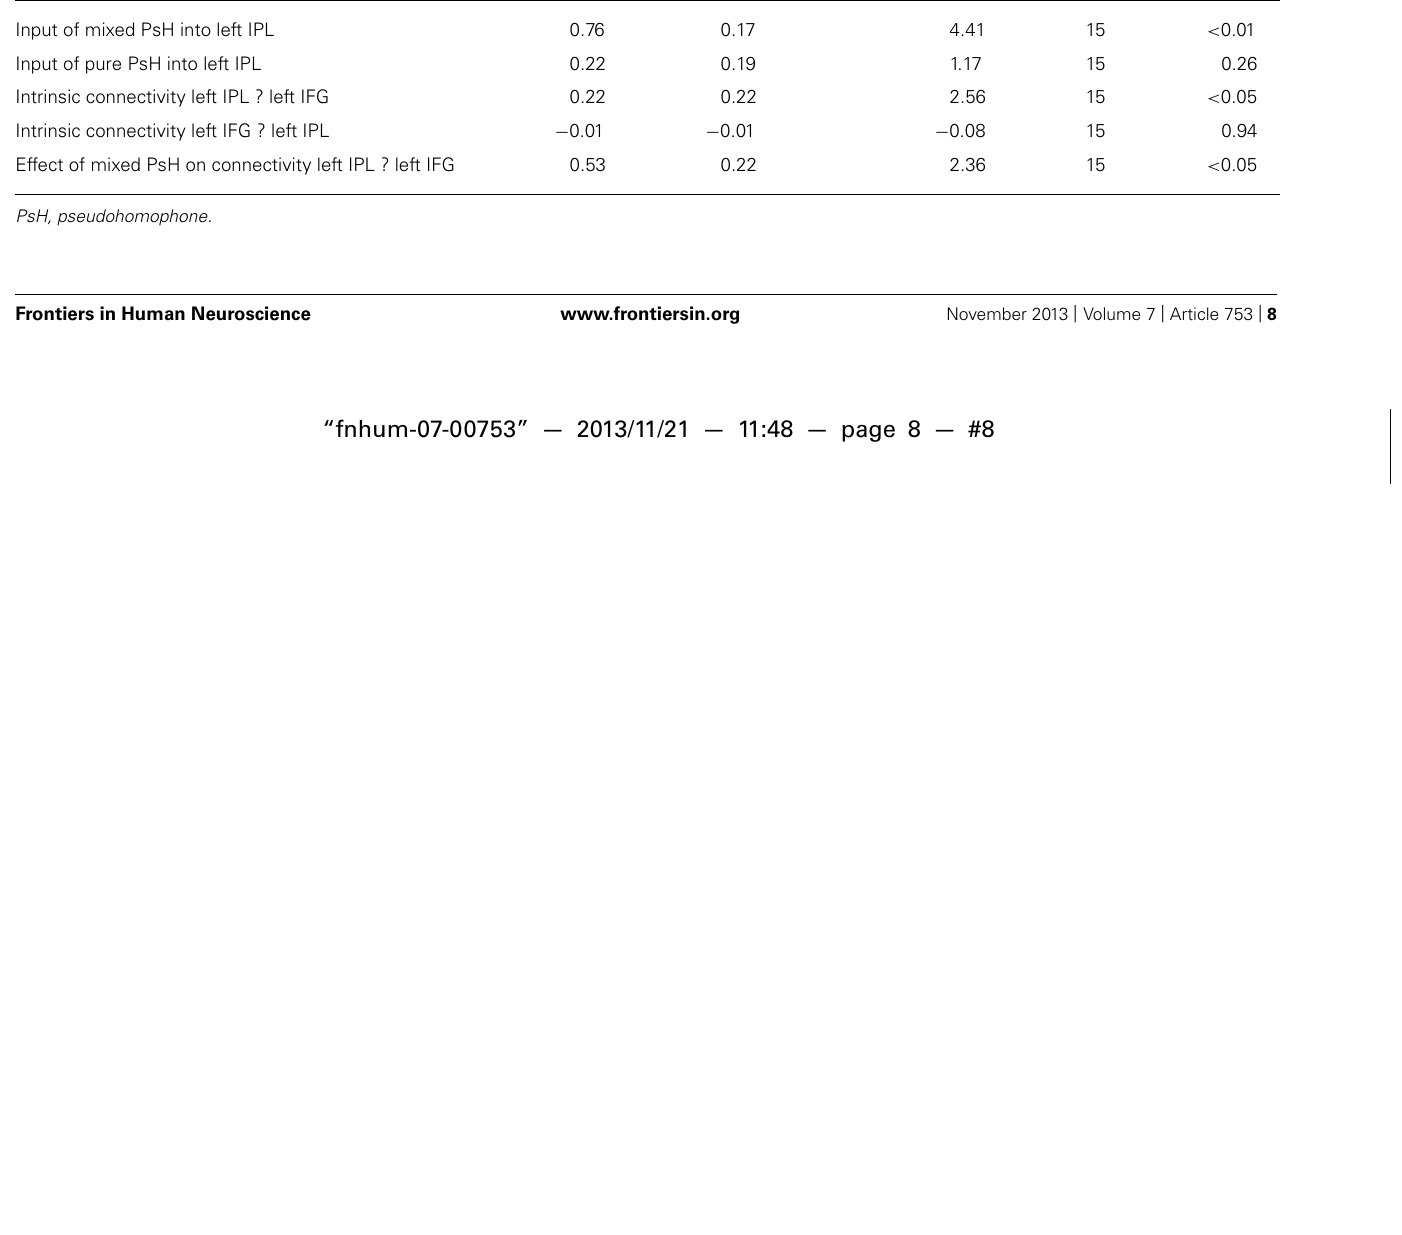
Table 4 |Average parameter estimates of Model 1, their standard error, and their significances in one-sample t -tests. Input of mixed PsH into left